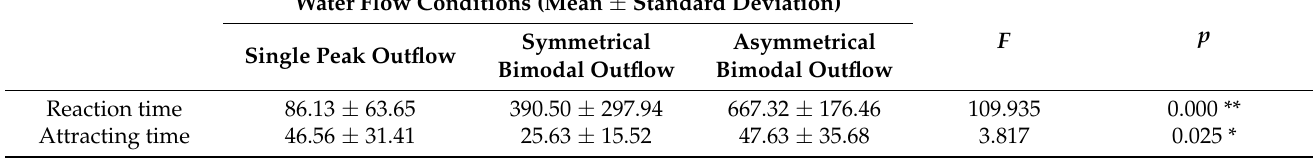
Figure 11. Average reaction time under different water flow conditions.